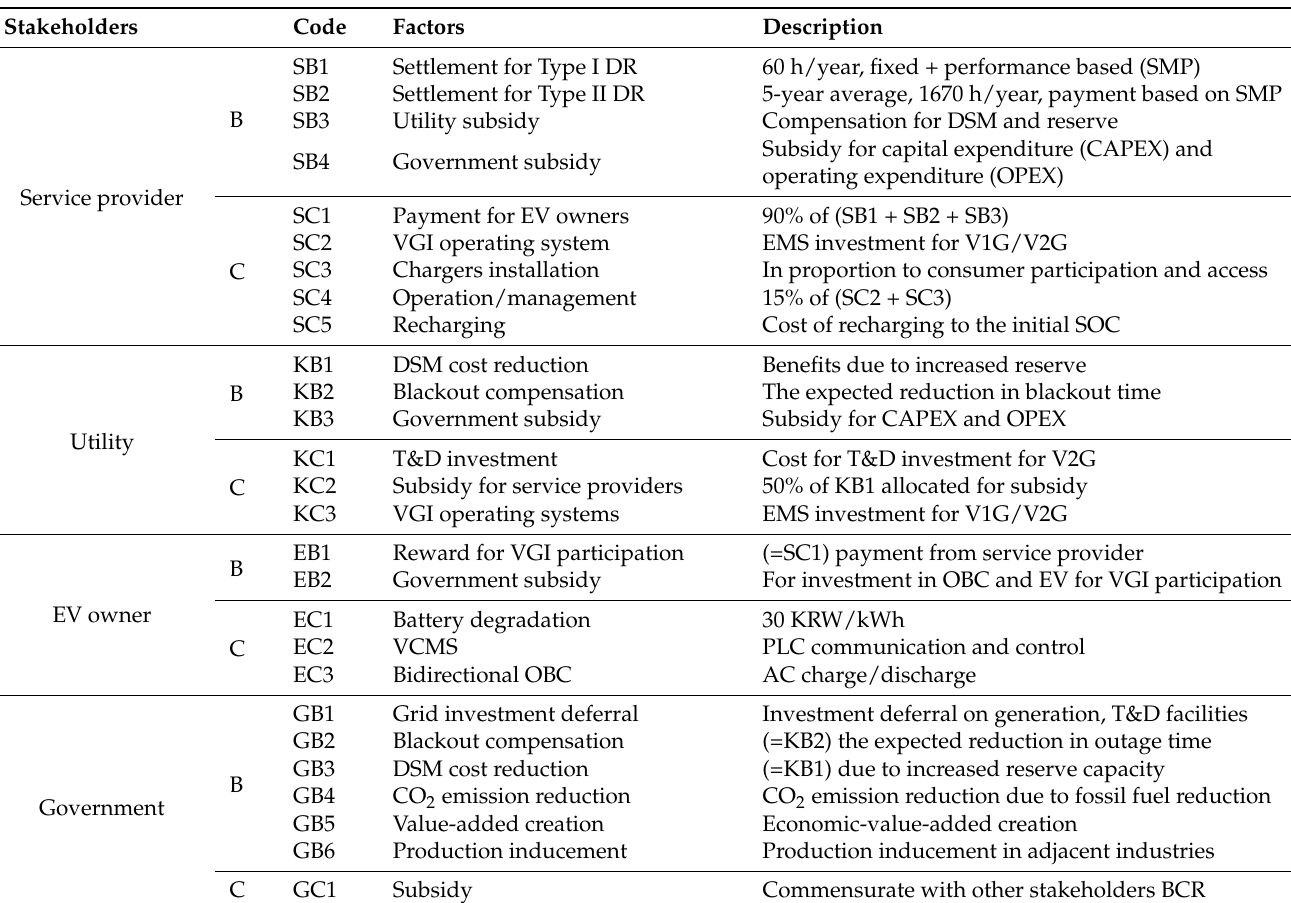
Table 2. The benefits and costs for each stakeholder.